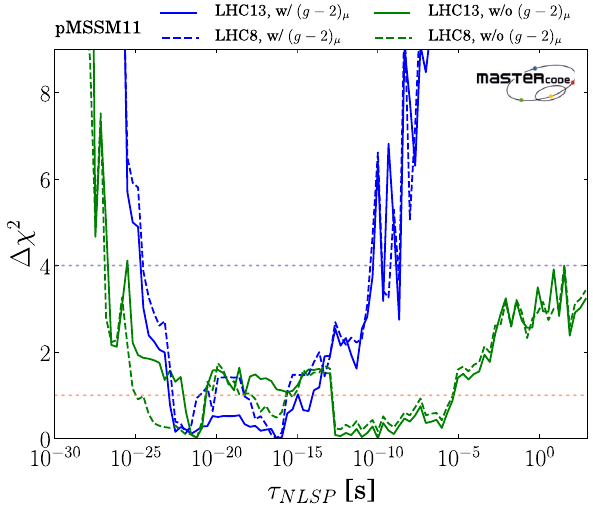
Fig. 18 One-dimensionalprofilelikelihoodplotfortheNLSPlifetime, τ NLSP , including all possible NLSP species (cid:2) 10 − 17 ( 10 − 10 ) s at the 95% CL in fits including LHC 13- TeV with (without) the ( g − 2 ) μ constraint, with just a